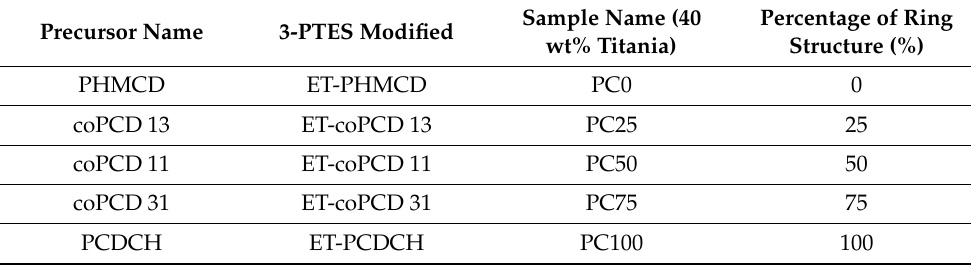
Table 1. Summary of the precursor and sample